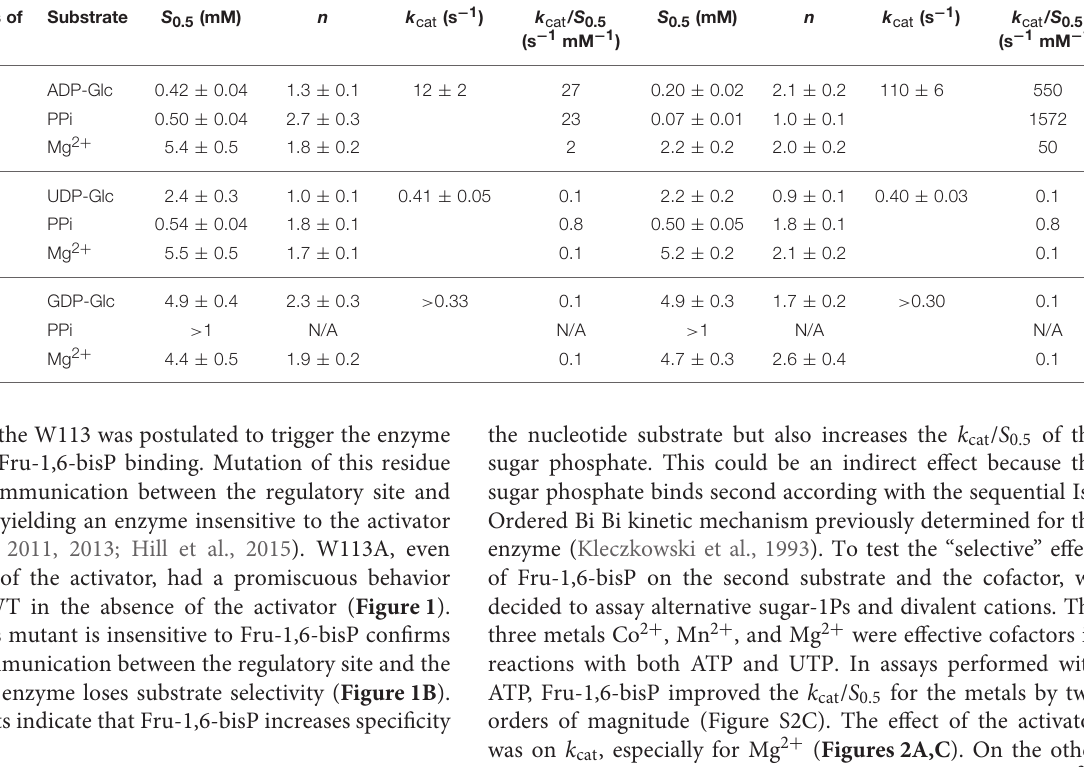
TABLE 2 | Kinetic parameters for substrates of the E. coli ADP-GlcPPase in the pyrophosphorolysis direction. CONTROL + Fru-1,6-bisP Pyrophosphorolysis of